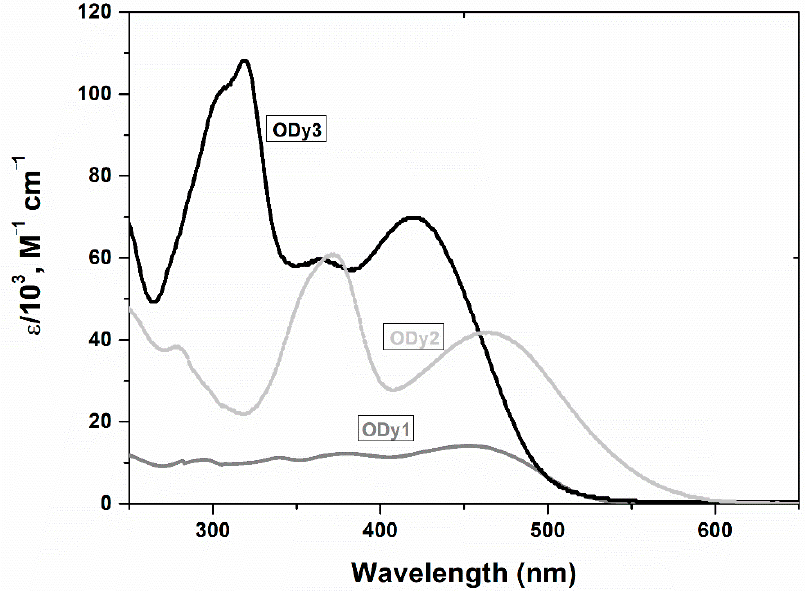
Figure 5. Molar absorption spectra of organic dyes ODy1 , ODy2 and ODy3 in CHCl 3 . Reprinted (adapted) with permission from ref. [82]. Copyright {2016} American Chemical Society.”.